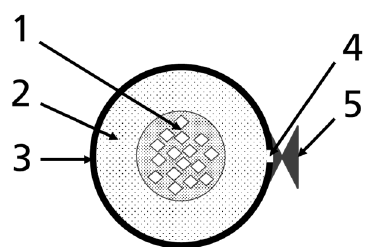
Figure 3. Exemplary sketch of the switching mechanism with nucleating agent dispersed in a small portion of the PCM (1), immobilized PCM layer (2), encapsulation layer (3) with a small opening (4), and sealing mechanism (5).